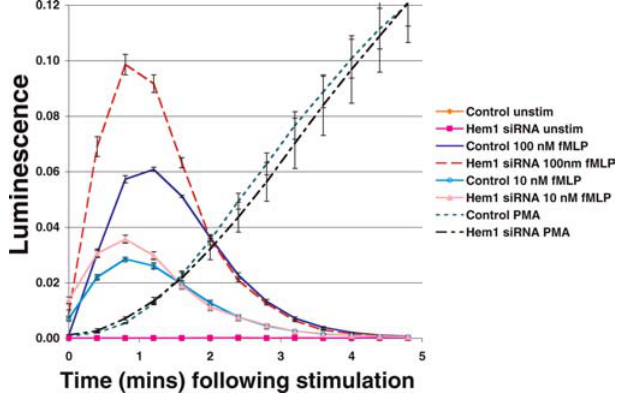
Figure 6. Hem-1 Knockdown Does Not Inhibit Reactive Oxygen Production in Response to Chemoattractant The 6- to 7-day differentiated HL-60 cells were stimulated with the indicated concentration of fMLP or PMA, and reactive oxygen production was monitored in a luminometer. (Control unstimulated cells are superimposable with Hem-1 siRNA unstimulated cells.) Results are shown with standard error for cells stimulated in triplicate at 37 8 C. DOI: 10.1371/journal.pbio.0040038.g006 PLoS Biology |